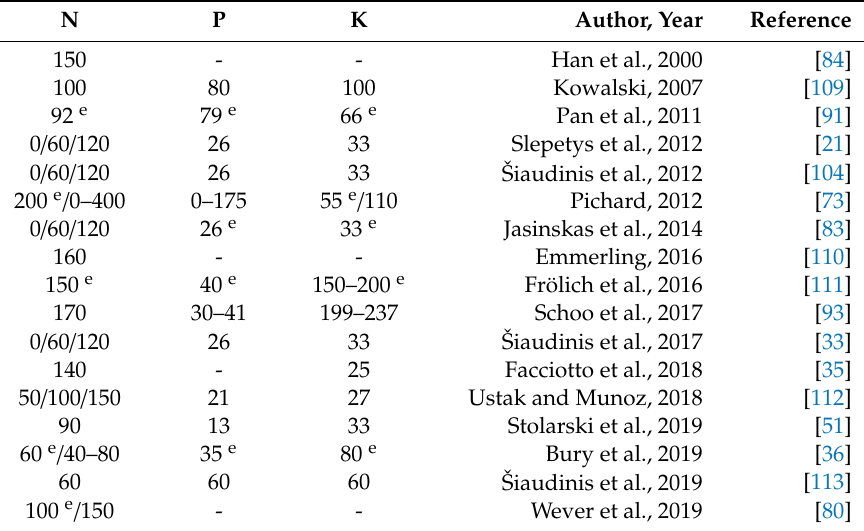
Table 4. Reported fertiliser application rates of S. perfoliatum (in kg ha − 1 ). N P K